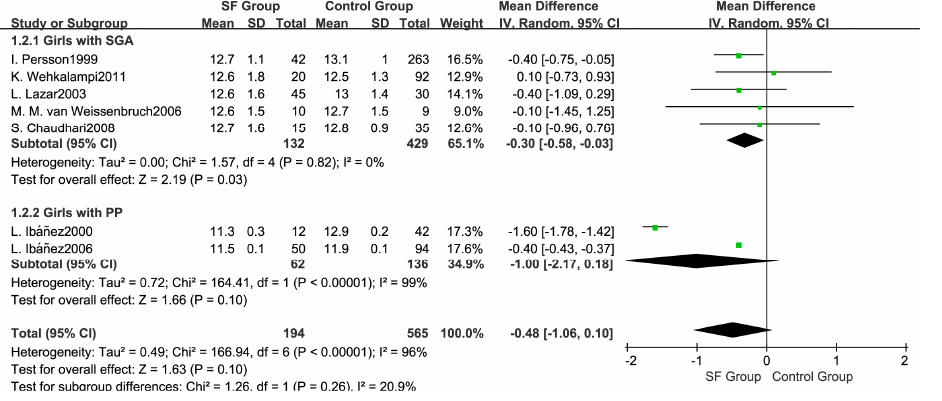
Figure 6. Forest plot for the age at menarche between SF group and Control group.